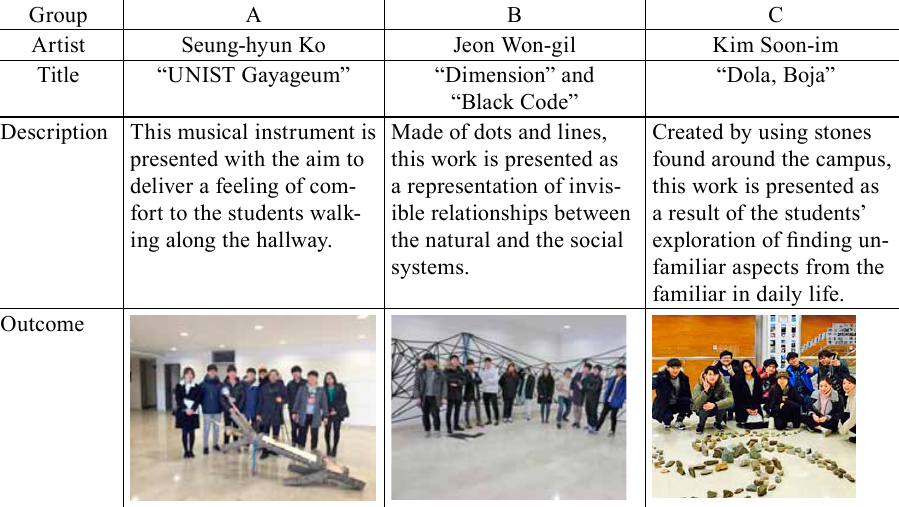
“black Code” Made of dots and lines, Created by using stones this work is presented as found around the campus, a representation of invis- this work is presented as ible relationships between a result of the students’ the natural and the social exploration of finding un - systems. familiar aspects from the familiar in daily life.